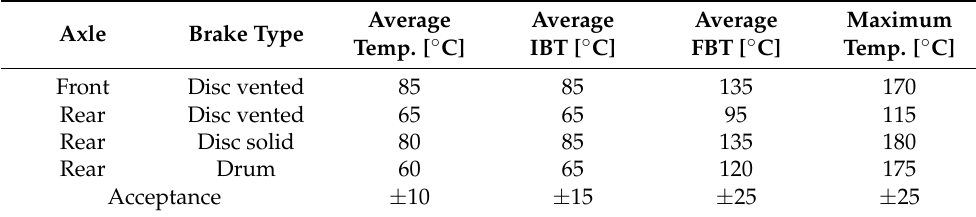
Table 1. PMP (Particle Measurement Program) temperature specifications for brake discs during trip #10 of the WLTP (Worldwide harmonized Light-Duty vehicles Test Procedure) brake cycle (IBT = initial brake temperature; FBT = final brake temperature)